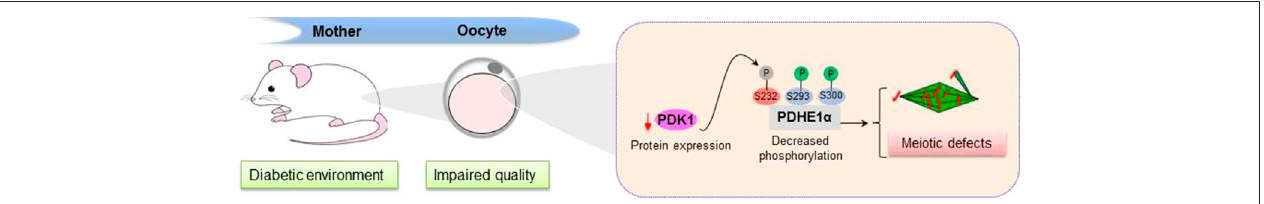
FIGURE 6 | Diagram illustrating how PDK1 reduction affects oocyte quality from diabetic mice. Exposure of oocytes to maternal diabetes induces a signi fi cant reduction of PDK1, which results in a decreased in pSer232-PDHE1 α , consequently leading to de fi cient spindle assembly and chromosome alignment in metaphase